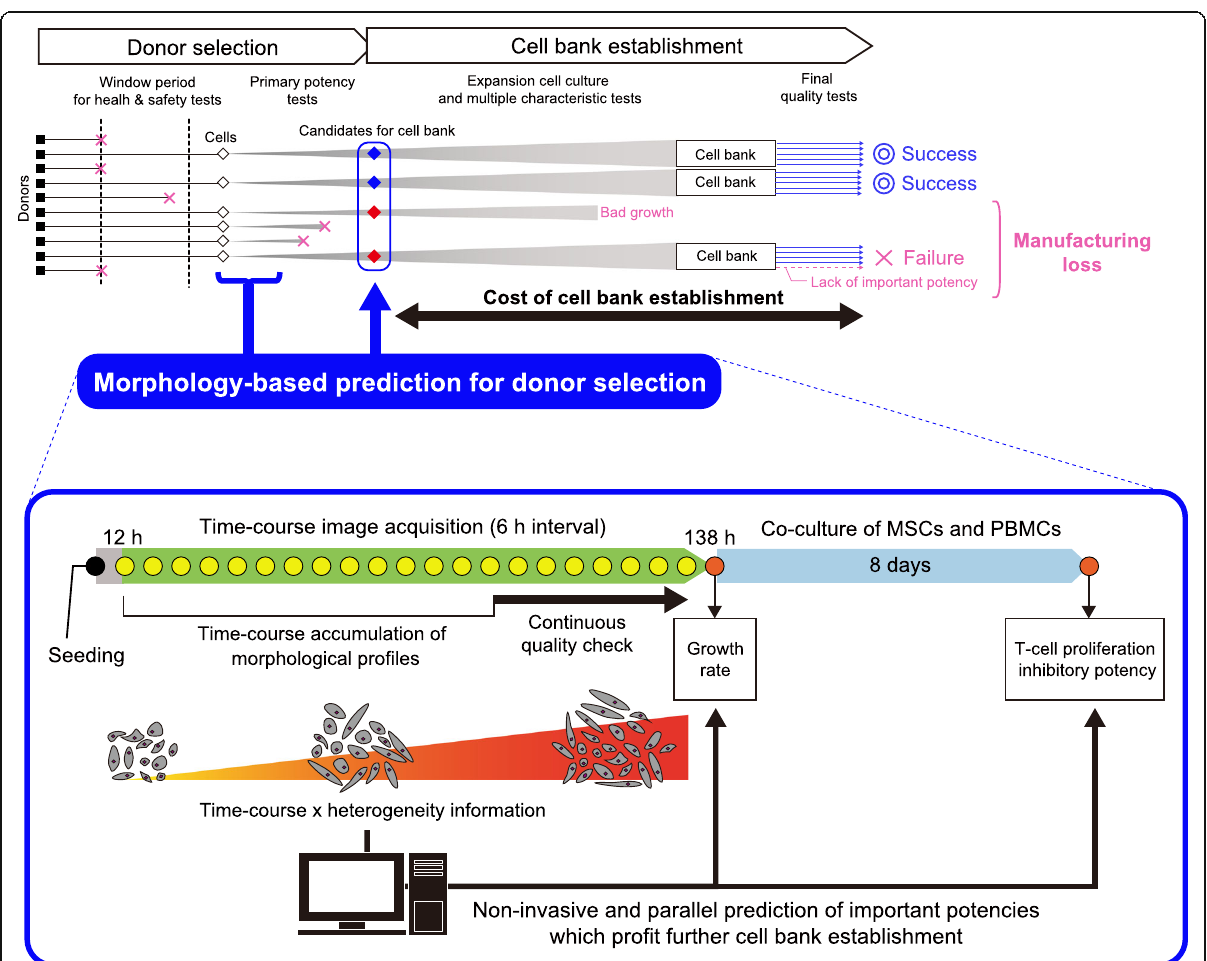
Fig. 1 Schematic of morphology-based parallel prediction for growth rate and T-cell proliferation inhibitory potency of MSCs for donor selection. This morphology-based prediction concept is designed to facilitate the donor selection stage to eliminate risky lots for further processing and support the effective cell bank establishment which can pass the final quality tests. The time-course accumulation of morphological profiles which describes morphological heterogeneity enables early and parallel prediction both potencies, and also enables continuous quality check till the final day of